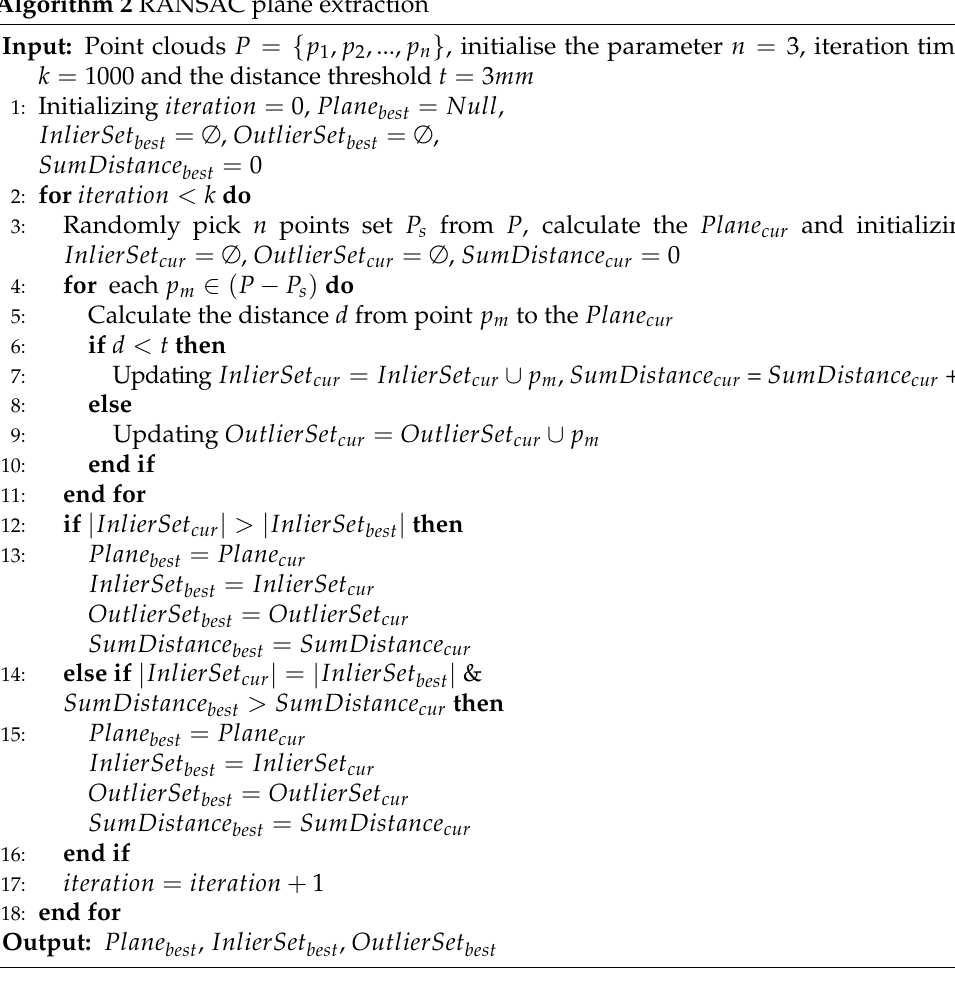
Algorithm 2 RANSAC plane extraction